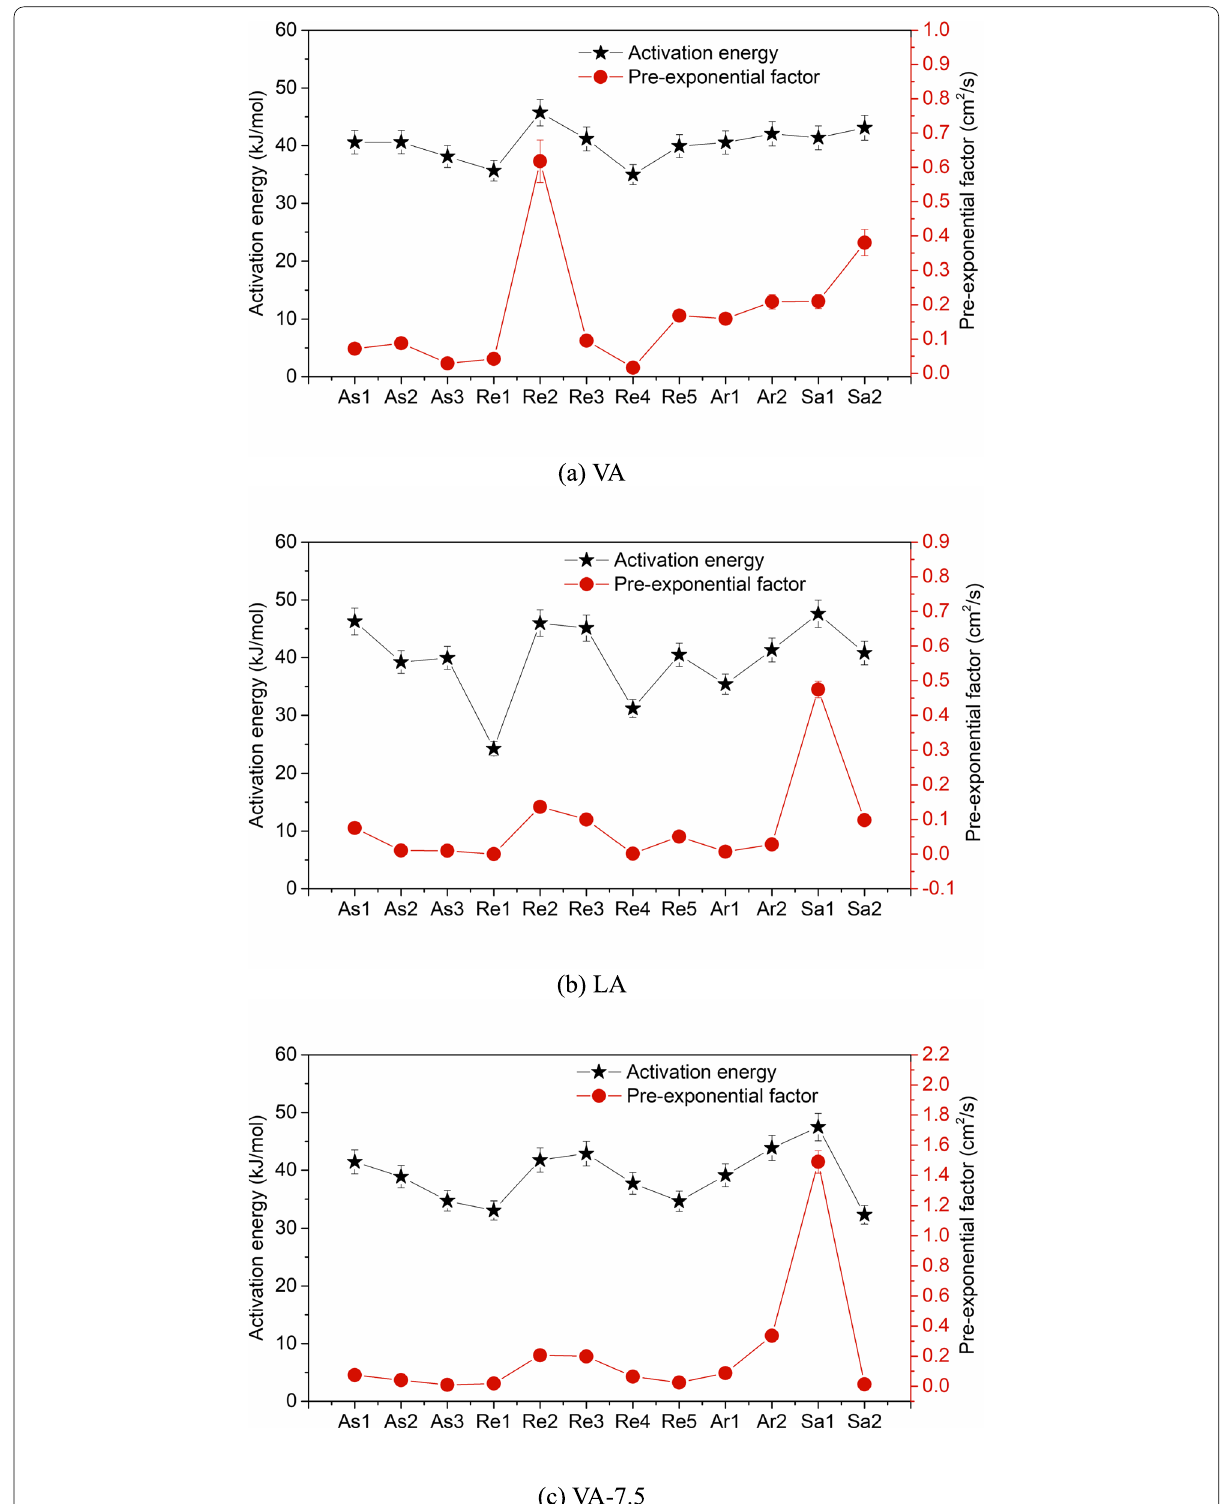
Fig. 23 Activation Energy and Pre-Exponential Factor of the Molecules in Asphalt Models: ( a ) VA, ( b ) LA, and ( c )